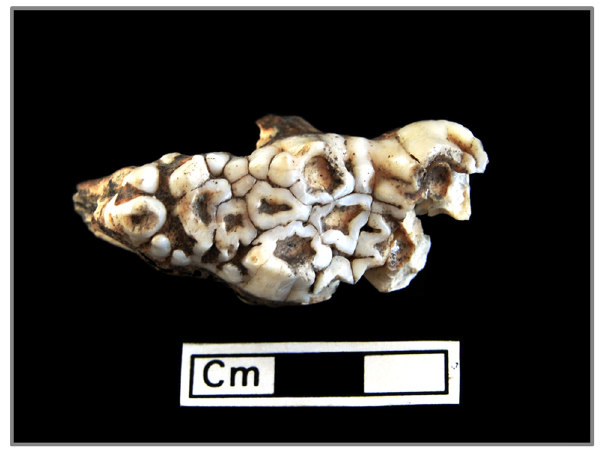
Figure 13: Isolated pig tooth ( from burial chamber, unit 15821, Space 327, TP Area, Level TP.O, Çatalhöyük East ) . ( Photo by K. Paw ł owska )